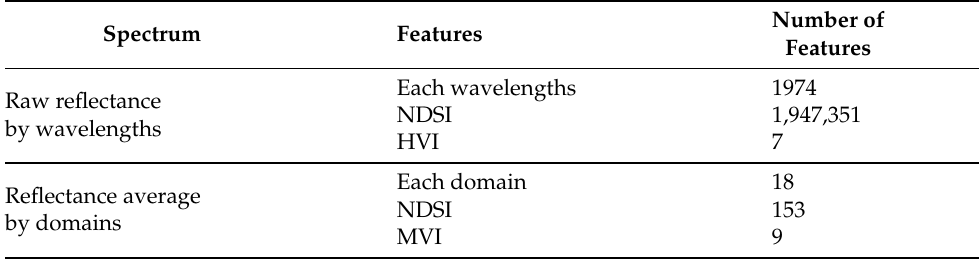
Table 8. Summary of available features. NDSI—Normalized difference spectral indices; HVI— Hyperspectral vegetation indices; MVI—Multispectral vegetation